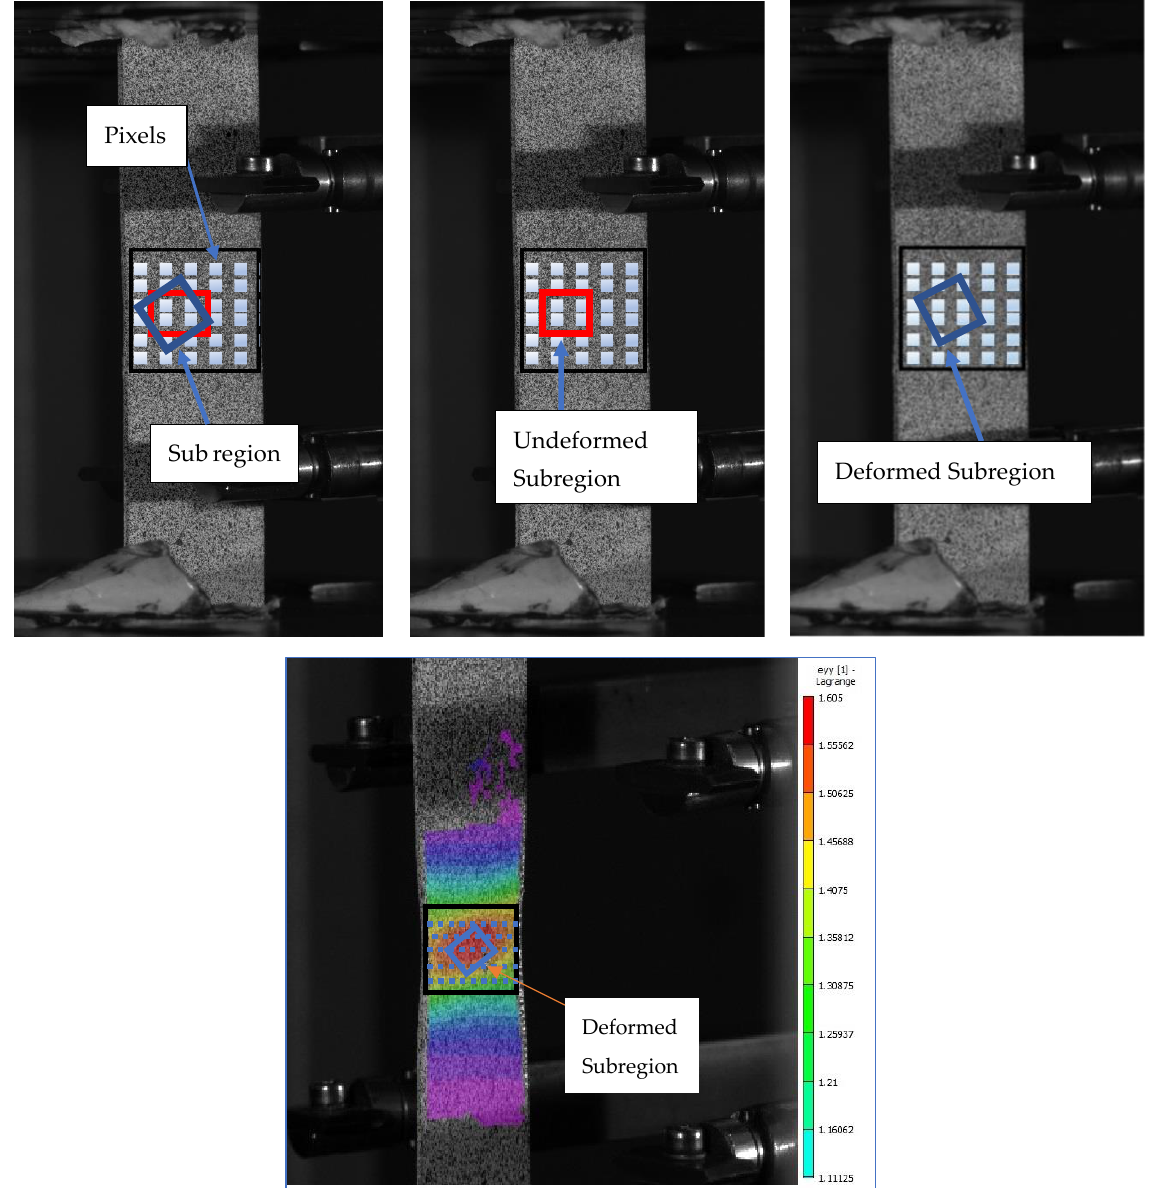
Figure 8. The figures show that the reverse search method searches the deformed sub-regions (the red and blue boxes) in the deformed image, which is constant and precalculated.